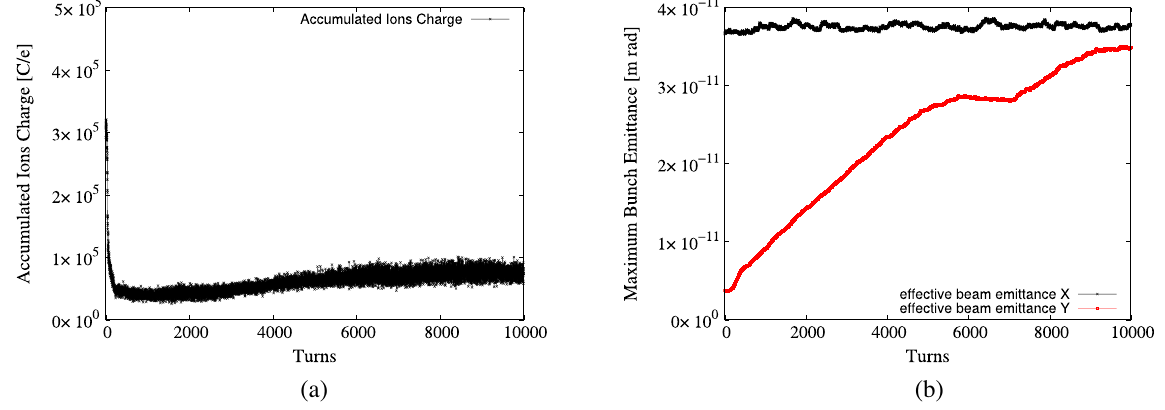
FIG. 9. Accumulated ion charge (a) and the maximum bunch emittance referenced to the ideal orbit (b) as functions of the passing turns; synchrotron radiation damping and quantum excitation are taken into account. The beam current is 10 mA, and the simulation results are given by the quasi-strong-strong